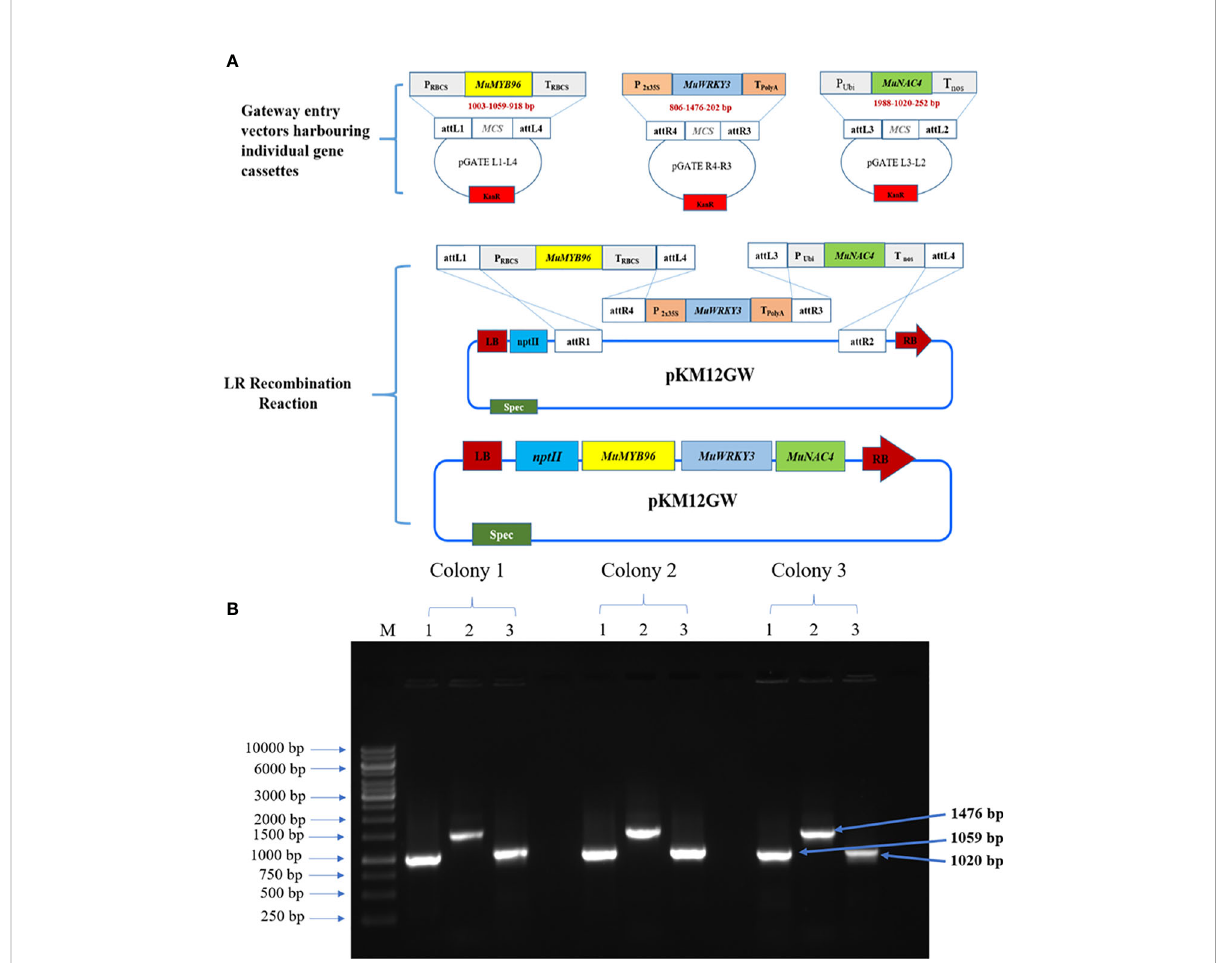
FIGURE 1 Development of multigene cassette harboring MuMYB96, MuWRKY3 and MuNAC4 genes: (A) . Over view of steps involved in the development of multigene construct through modi fi ed gateway cloning technology. (B) PCR con fi rmation of MuMYB96 (1059 bp), MuWRKY3 (1476 bp) and MuNAC4 (1020 bp) in Agrobacterium tumefaciens . Lane M: DNA ladder, Lane 1,2,3: positive